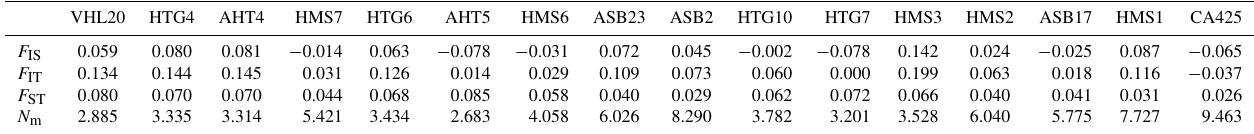
Table 3. F statistics and estimates of F IS , F IT , F ST and N m over all populations of the Tunisian horse breeds (AB, BA, AR and PS). VHL20 HTG4 AHT4 HMS7 HTG6 AHT5 HMS6 ASB23 ASB2 HTG10 HTG7 HMS3 HMS2 ASB17 HMS1 CA425 F IS